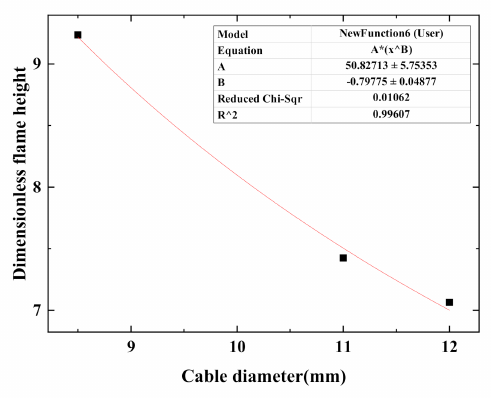
Figure 5. The relationship between the dimensionless flame height of a single cable and the cable diameter.